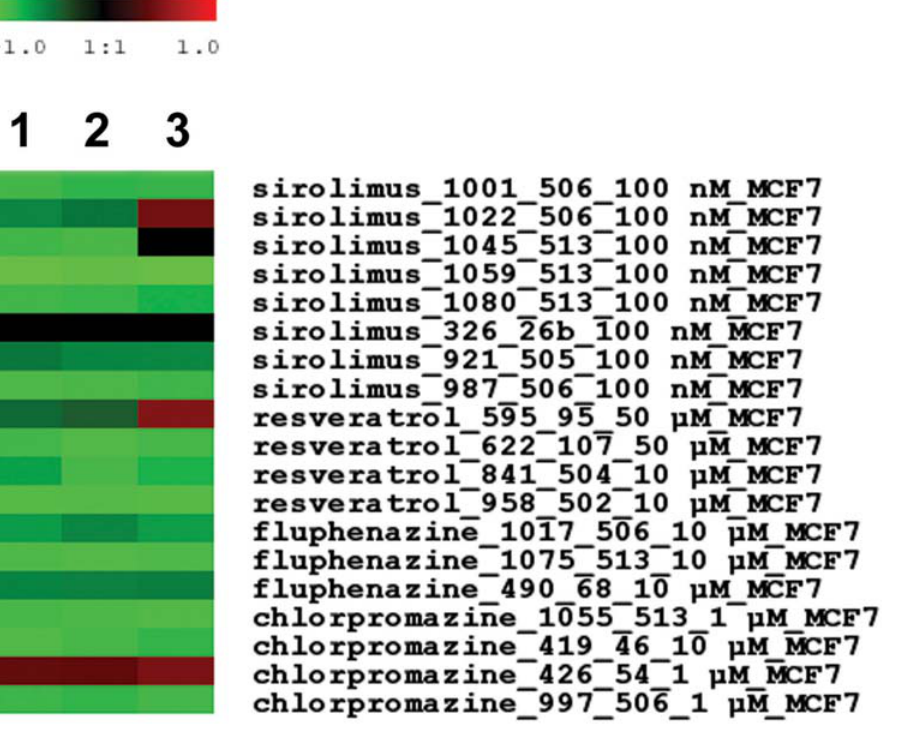
Figure 6. Connections between gene signatures induced by small molecule drugs in MCF-7 breast cancer cells and a query signature. The query signature consisted of the differentially expressed genes in ER-negative breast tumors comparing African-American with European-American patients. Shown is a heatmap with the color-coded connectivity score ( 2 1 to + 1) for individual sets of experiments exposing MCF-7 cells to sirolimus, resveratrol, or two phenothiazines, fluphenazine and chlorpromazine. The heatmap shows that negative correlations between drug-induced signatures and the query signature were found for multiple experiments with MCF-7 cells. Green: negative connectivity indicating an antagonist effect of the drug on the query signature. Black: no connectivity. Red: positive connectivity indicating an agonist effect. Different cutoffs were used for inclusion of differentially expressed genes in the query signature: (1) P # 0.01, (2) P # 0.01 and fold change at least 1.5- fold, (3) P # 0.05 and fold change at least 1.5-fold. The negative correlations between signatures induced by sirolimus, resveratrol, or chlorpromazine, and the query signature were statistically significant at P permutation , 0.05, respectively, in the combined analysis with n=8 for sirolimus, n=4 for resveratrol, and n=4 for